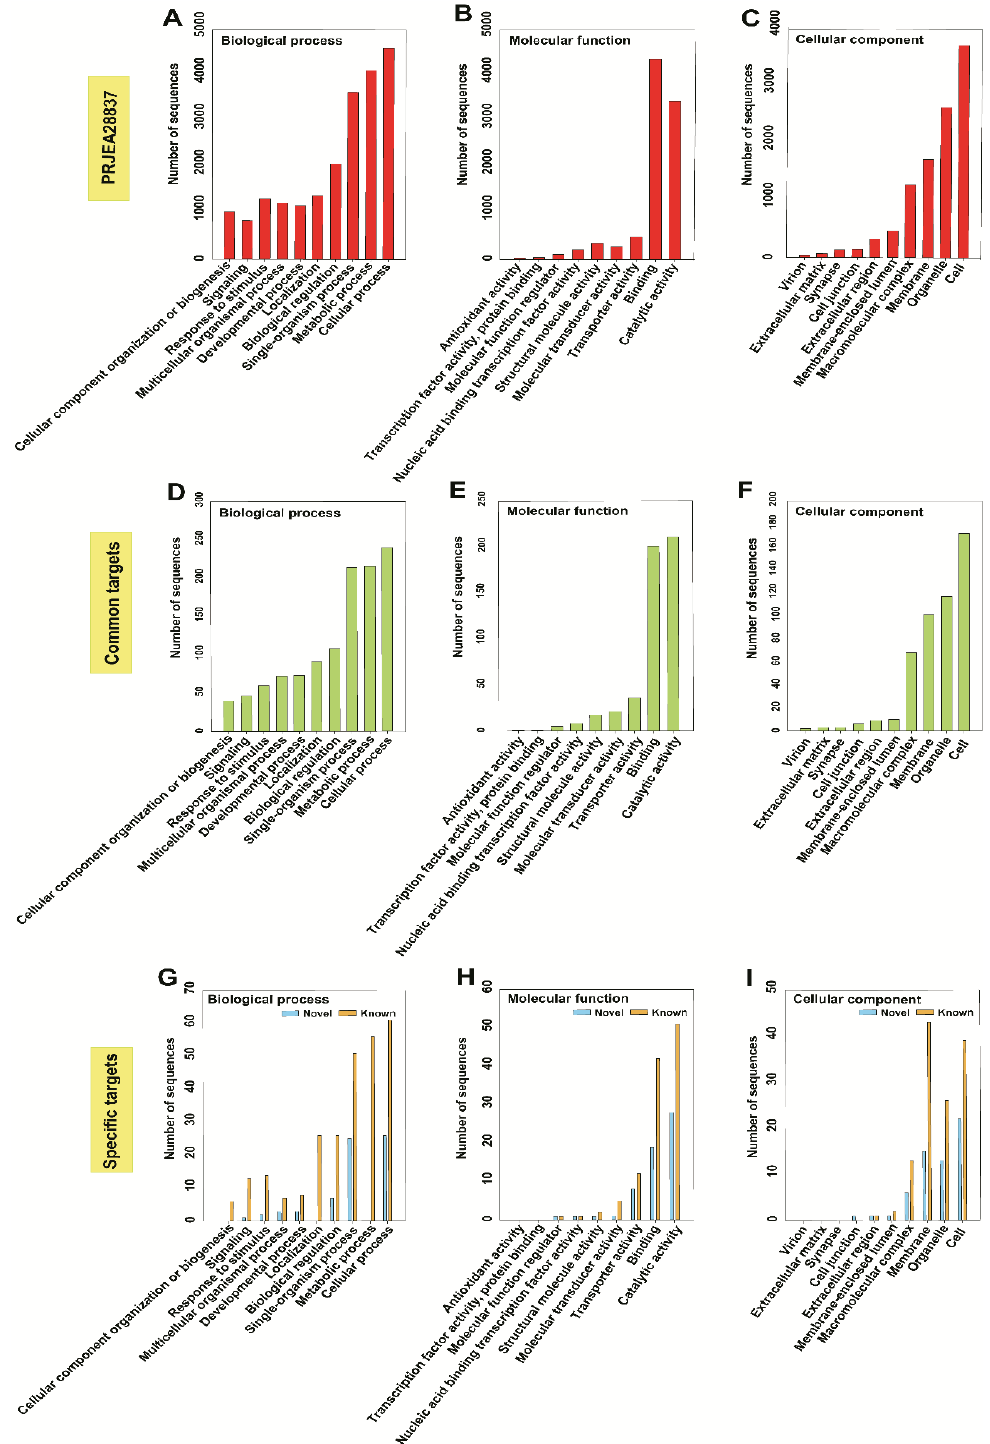
Figure 7. GO distribution of miRNA-targeted mRNAs predicted using miRanda, PITA, and RNAhybrid programs. ( A – C ) reference targets; ( D – F ) miRNA targets common across all stages; ( G – I ) known and novel miRNA targets specific to stages categorized into biological processes, molecular functions, and cellular components.